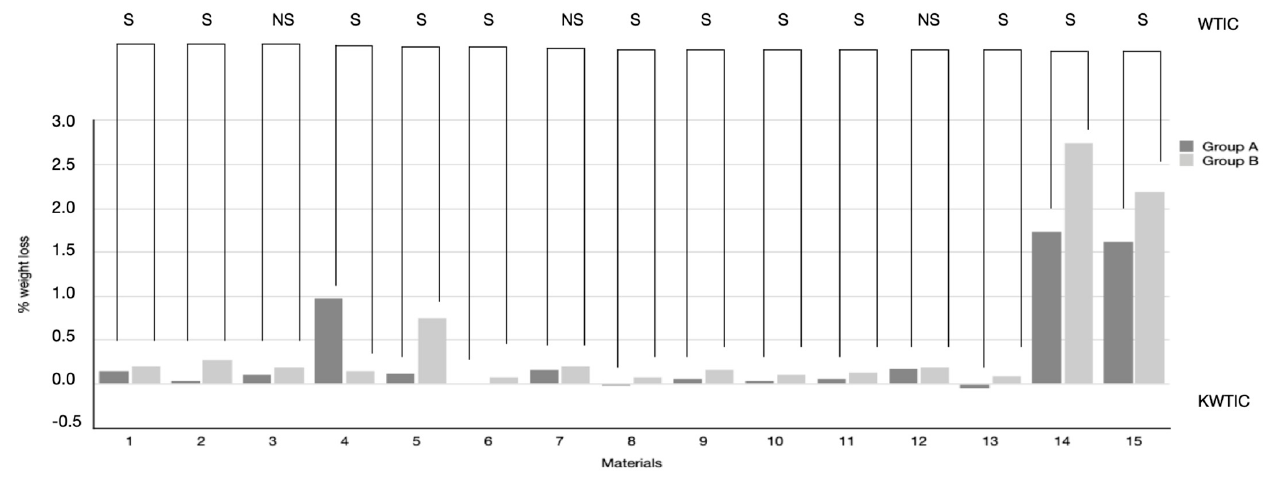
Figure 1. Representation of weight loss percentages after acid immersion in Coca-Cola at 4 °C (Group A) and Coca-Cola at 37 °C (Group B) for restorative materials tested. Wilcoxon test results for intragroup significance (WTIC) are reported in the rows for each material, and they evaluate the differences between Group A and B for each material (S: significant; NS: not significant).